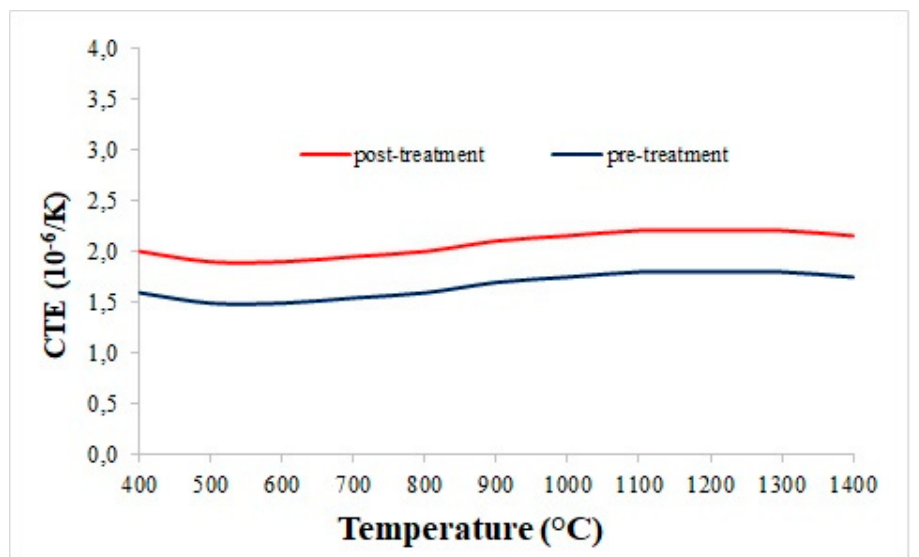
Figure 10. C/C thermal expansion coefficient before and after the stabilization cycle.